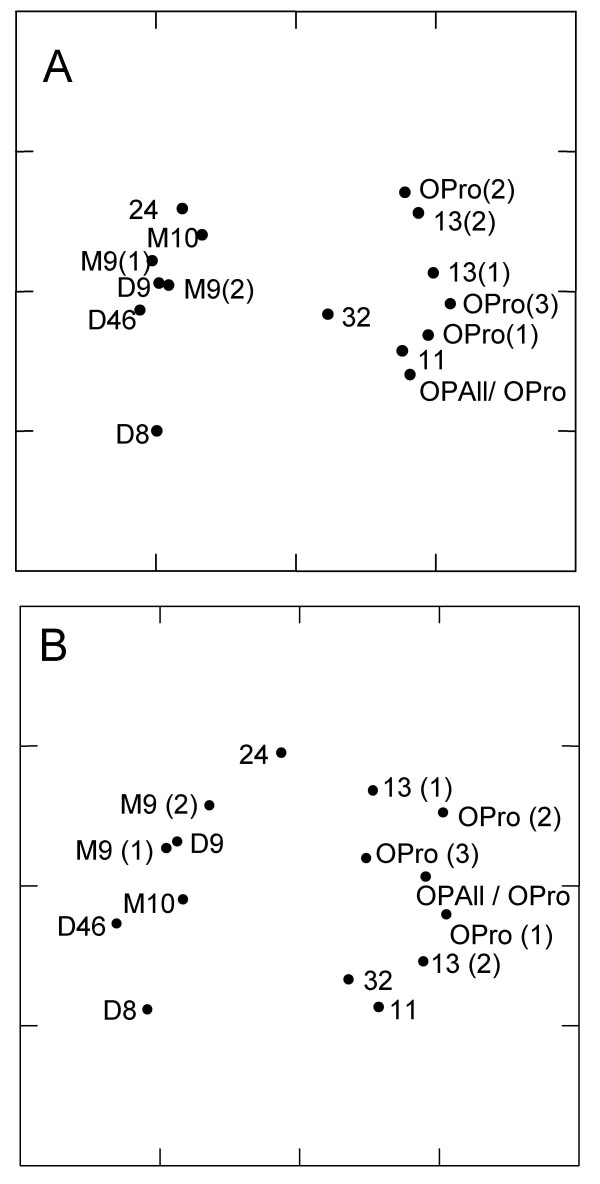
Non-metric multidimensional scaling (NMDS), assessing the pairwise similarities of projection patterns among cases. Cases are identified by the area of tracer injection. Multiple cases with injection of tracer in the same area are identified by the number in parenthesis after each case. Since NMDS configurations are invariant to rotation, the coordinate axes provide a scale of relative similarity, but do not prescribe specific dimensions, and are left unlabeled. (A) ipsilateral cases; (B) contralateral cases. Similarity was defined as the correlation of relative retrograde projection patterns resulting from the injections. The two main projection systems apparent in the diagram consist of predominantly mediodorsal areas (to the left), and basoventral areas (to the right) for both ipsilateral (A) and contralateral (B) projections.